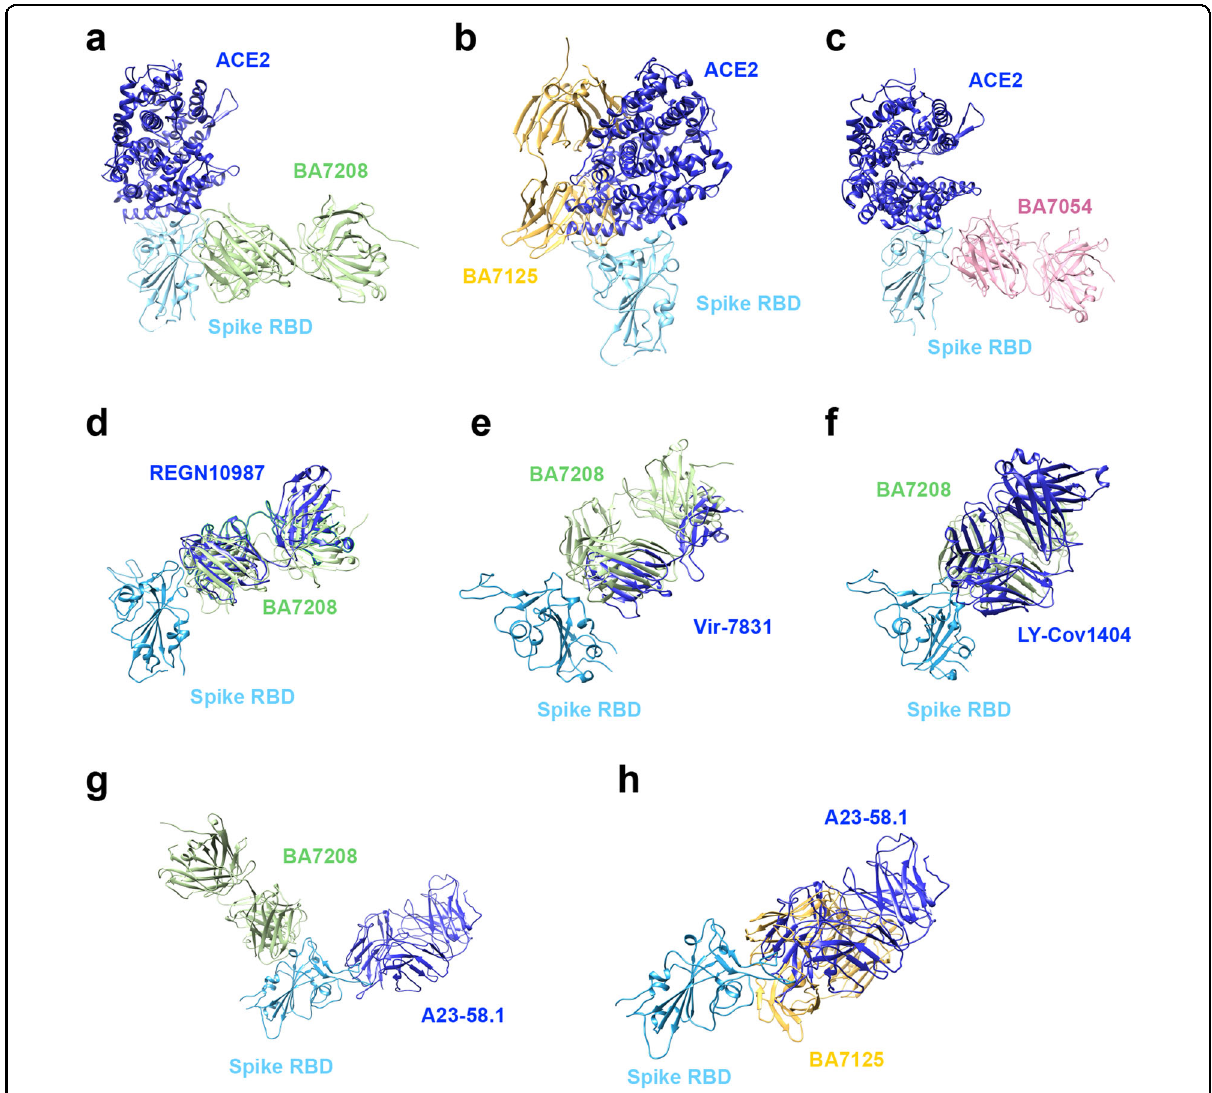
Fig. 5 BA7208/BA7125 structure superimpose analysis. a The complex of RBD (cyan) and BA7208-Fab (green) is superimposed with complex of RBD (cyan) and ACE2 (blue). b The complex of RBD (cyan) and BA7125-Fab (yellow) is superimposed with complex of RBD (cyan) and ACE2 (blue). c The complex of RBD (cyan) and BA7054-Fab (pink) is superimposed with complex of RBD (cyan) and ACE2 (blue). d – g The complex of RBD (cyan) and BA7208-Fab (green) is superimpose with complex of RBD (cyan) and antibodies (blue) REGN10987, Vir-7381, LY-Cov1404, and A23-58.1, respectively. h The complex of RBD (cyan) and BA7125-Fab (yellow) is superimposed with complex of RBD (cyan) and A23-58.1 antibody